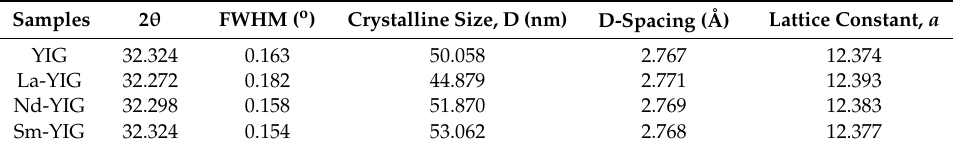
Table 2. Measured and calculated parameter of RE-YIG nanoparticles based on (420) peak.